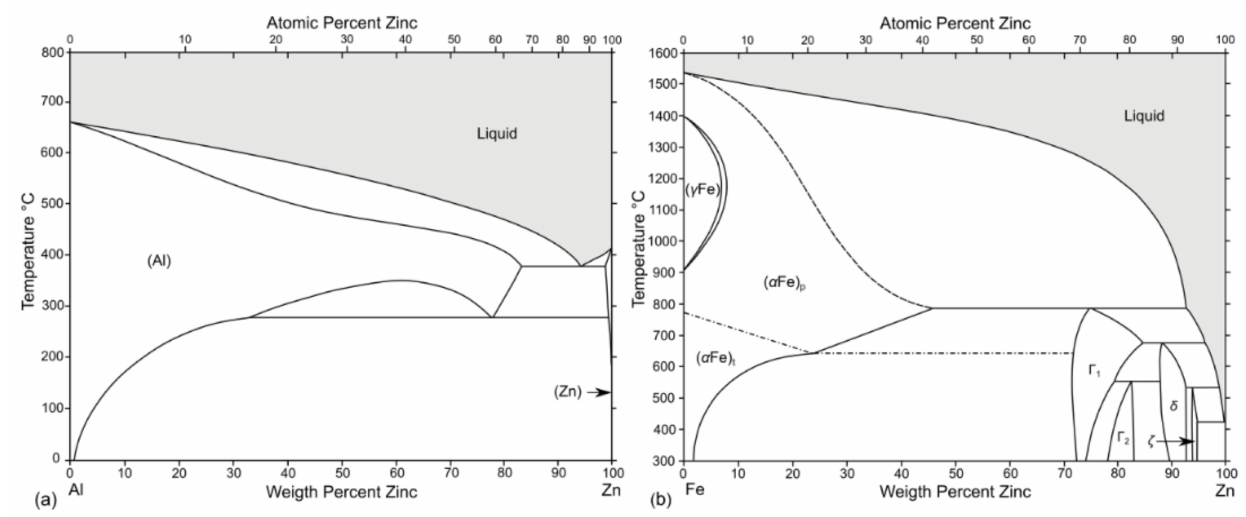
Figure 18. ( a ) Binary Al-Zn and ( b ) Fe-Zn phase diagrams. Redrawn from [88] with